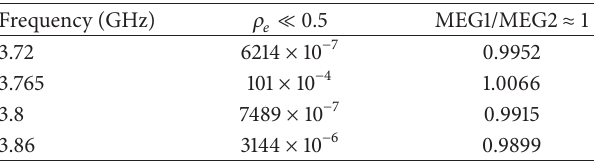
Table 1: Diversity parameters of the proposed tunable filter-